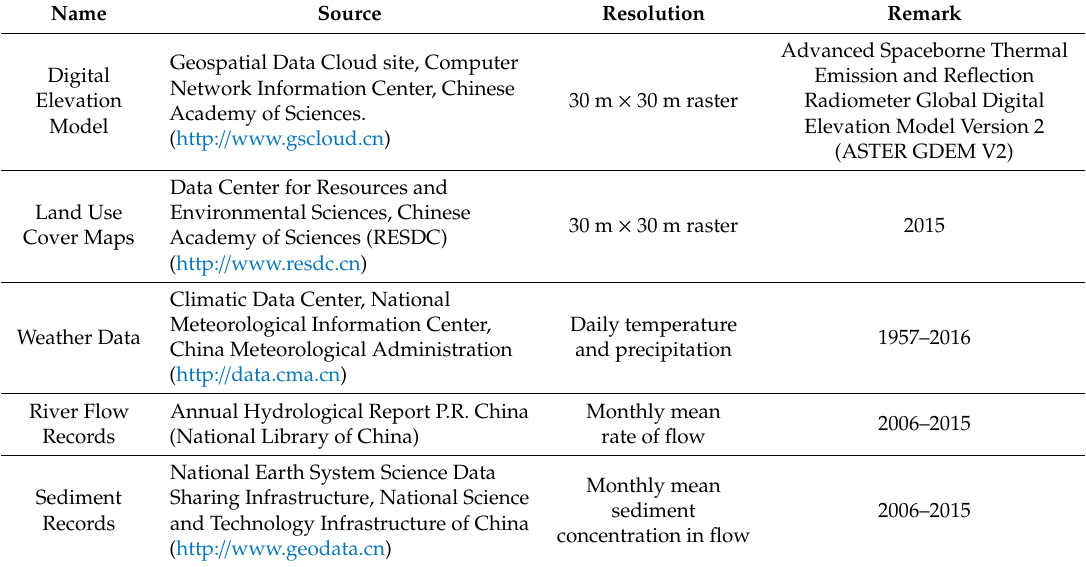
Table 1. Sources of the input data used in this